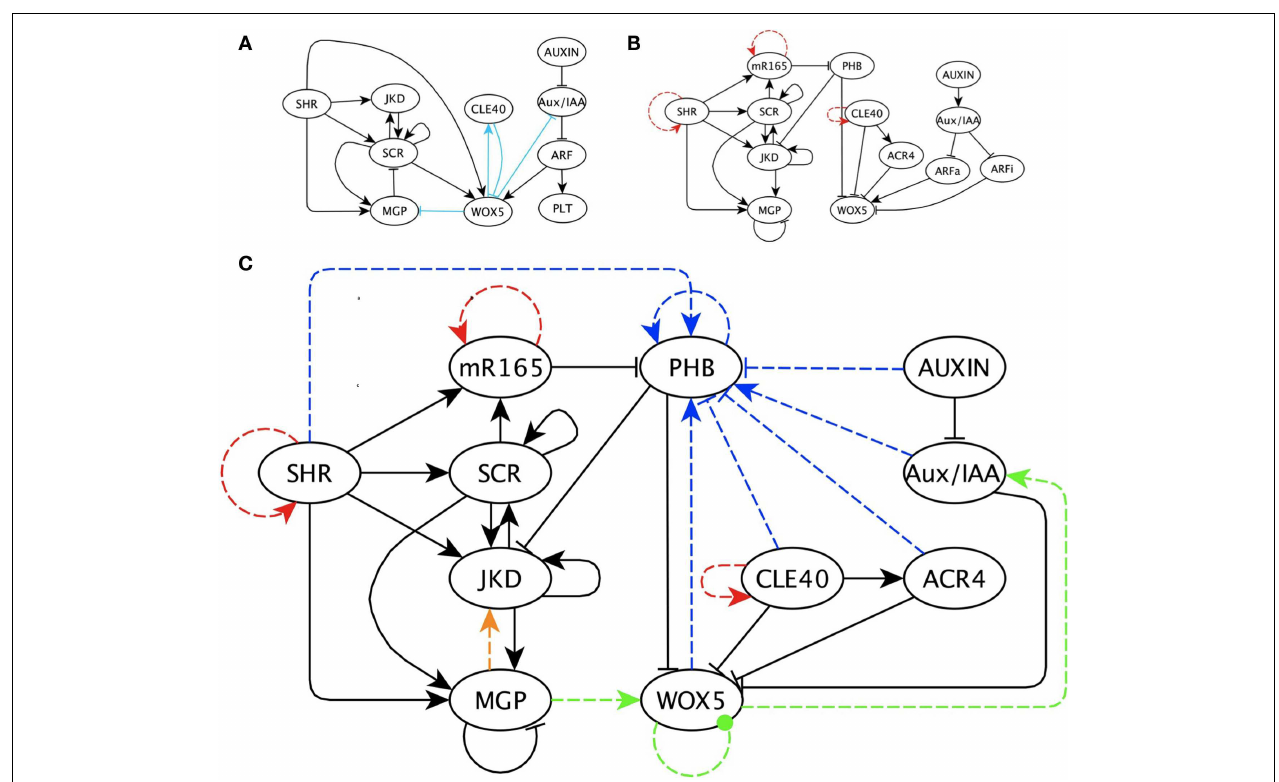
however, these nodes are available in Supplementary Material.Yellow, green and blue edges are the three predicted interactions required to recover the expected attractors and are grouped according to the node’s functions.The blue edges always indicate regulation of PHB.The yellow edge is a positive regulation of JKD by MGP.The green edges correspond to regulation ofWOX5.The dotted green edge indicates a negative or positive regulation ofWOX5 by